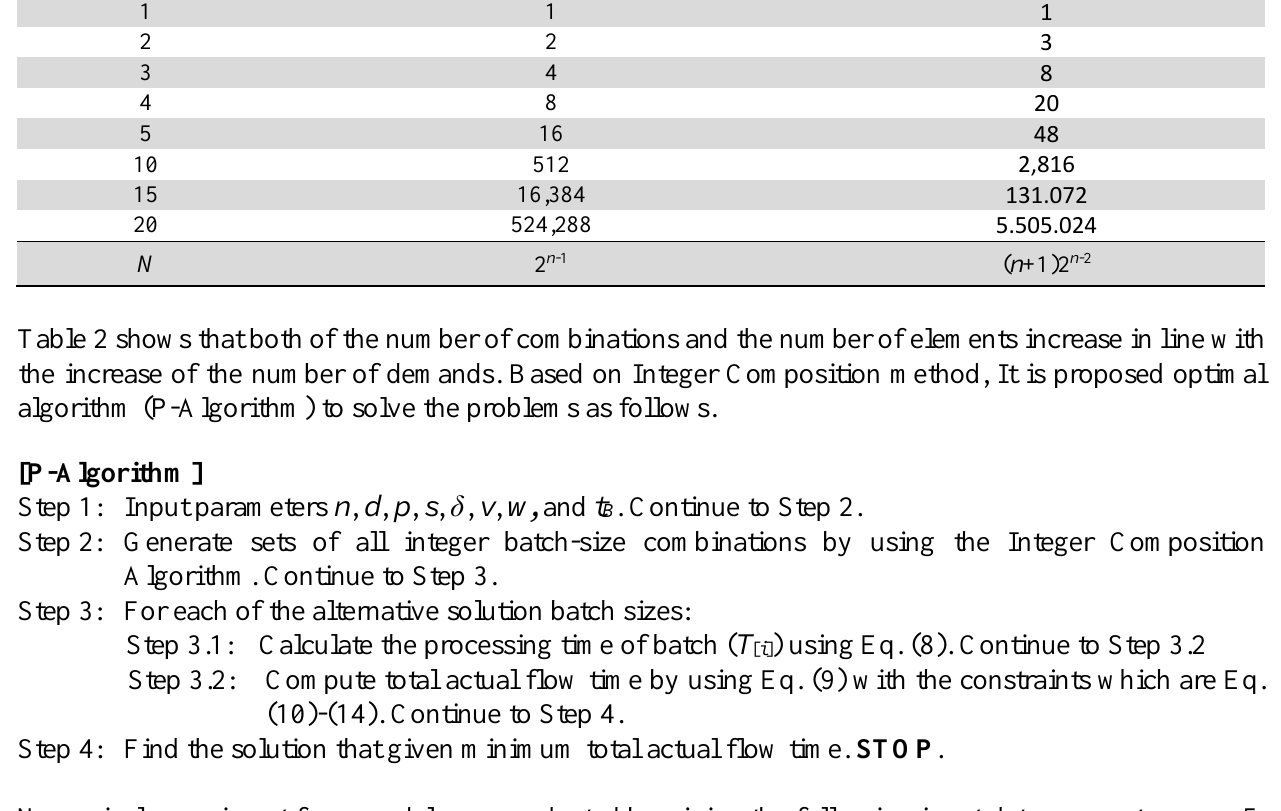
Testing Results for the number variety of demands Demands ( n ) The total quantity of combinations ( f ( n )) The total quantity of